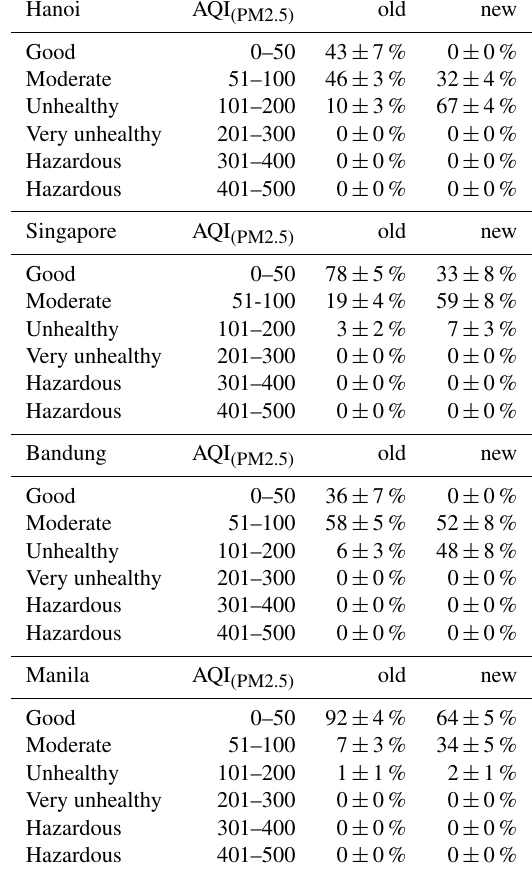
Table 6. The frequency of various daily air pollution levels in Hanoi, Singapore, Bandung, and Manila derived using 24h PM 2 . 5 concentration with (new) and without (old) the missing anthro- pogenic aerosol components in FFBB during 2002–2008. Hanoi AQI